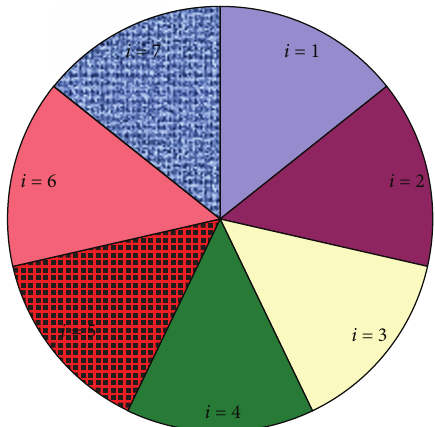
Figure 5: Working principle of multitraining and prediction ( 𝑖 = 1 means that the first six datasets were used for prediction validation, and the rest of the data were used as the training model; 𝑖 = 2 means that the second six datasets were used for prediction validation, and the rest of the data were used as the training model; ... , 𝑖 = 6 means that the last six datasets were used for prediction validation, and the rest of the data were used as the training